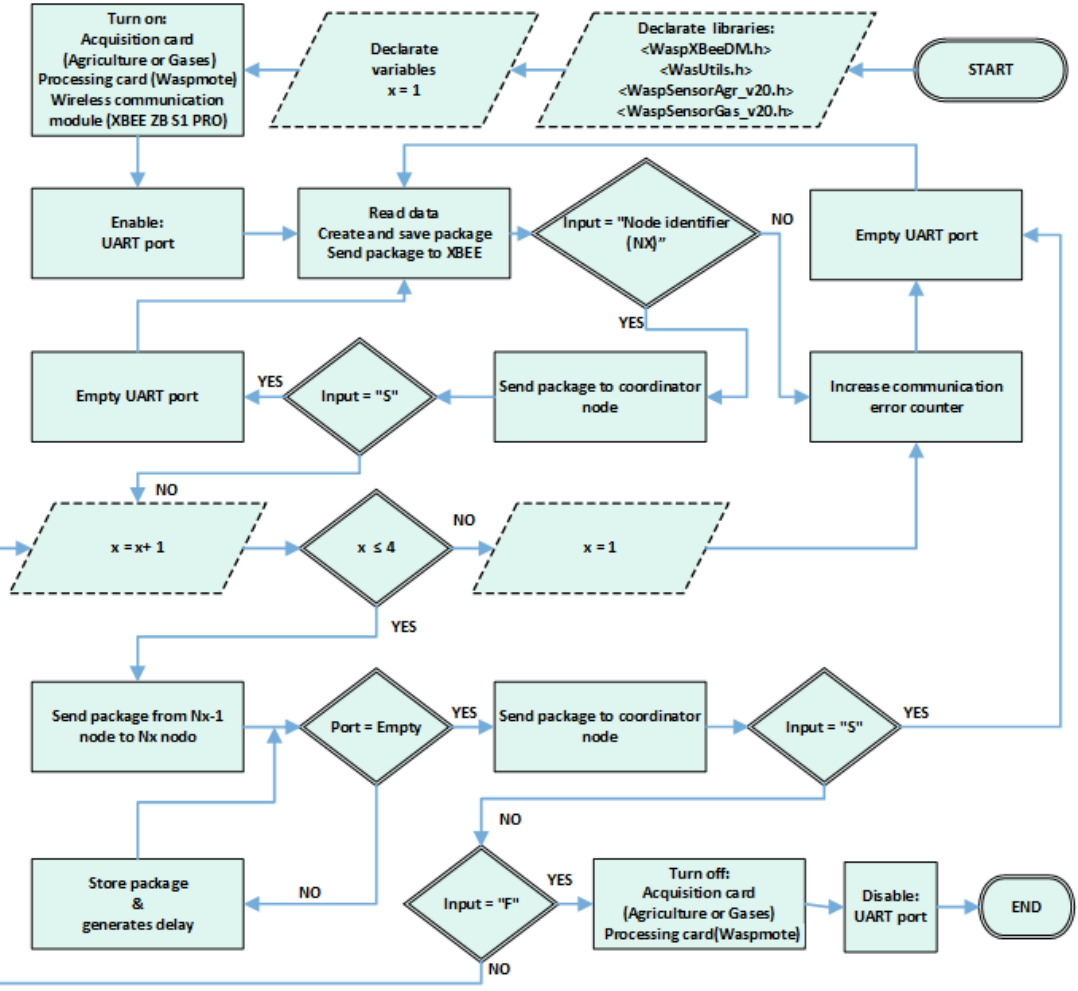
Figure A2. Flowchart of logic programming sensor nodes of the DigiMesh